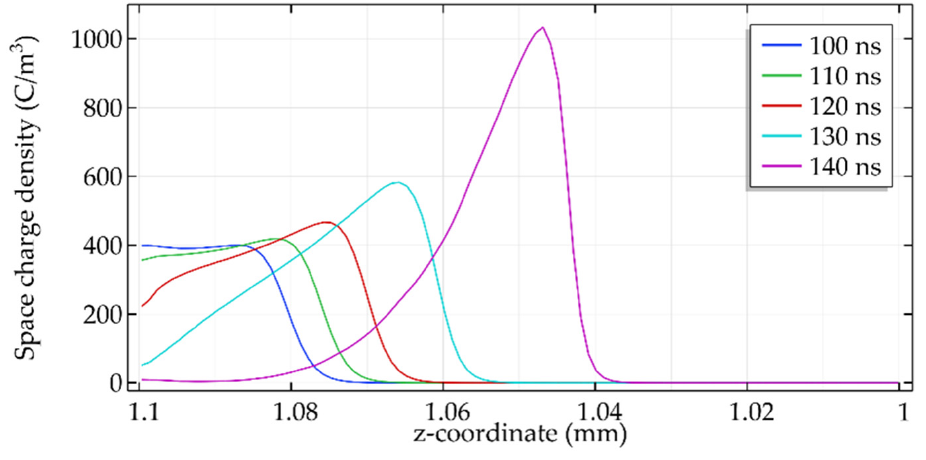
Figure 9. Space charge density (C/m 2 ) along the line ( O ) at several instants in the 1st